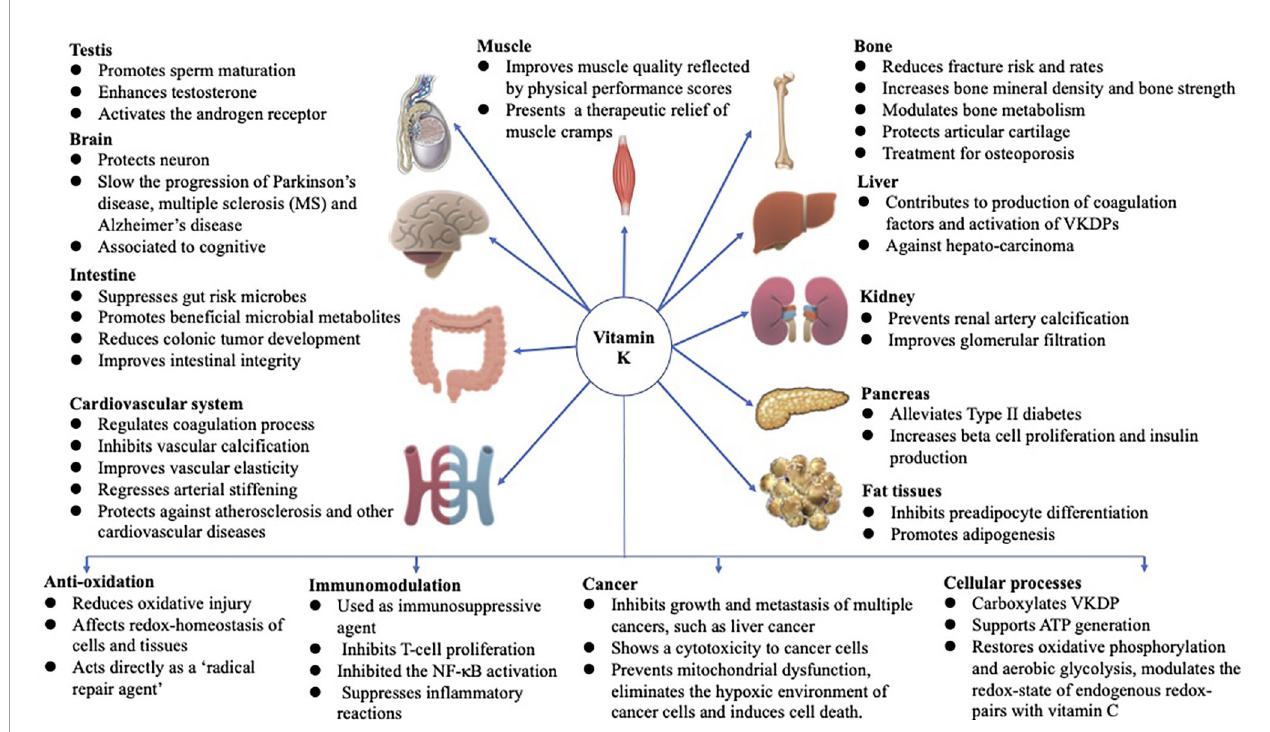
FIGURE 3 | Functions of VK in multiple-organ systems, such as testis (9), brain (10 – 14), intestine (15 – 17), muscle (18, 19), bone (20 – 22), liver (7, 23), kidney (24, 25), pancreas (26, 27), fat tissues (28 – 30), and cardiovascular system (31 – 34), and biological processes involved in anti-oxidation (3, 4), immune response and anti- in fl ammation (5, 6), and cancer progression (7, 8), and associated with protective and promoting roles in diverse organs or tissues throughout the human body are summarized above. The fi gure is in a non-editable